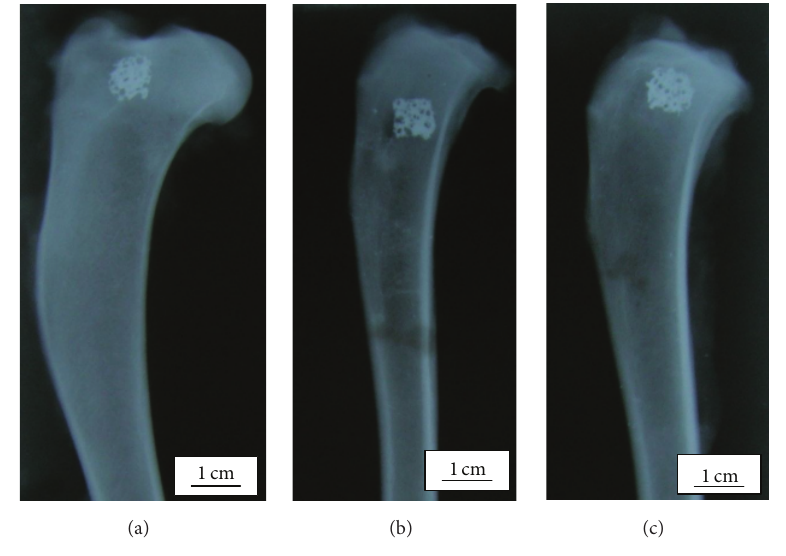
Figure 3: (a, b, c) 2nd, 4th, and 6th month radiography. Table 4: Mechanic properties of some different alloys and bone.